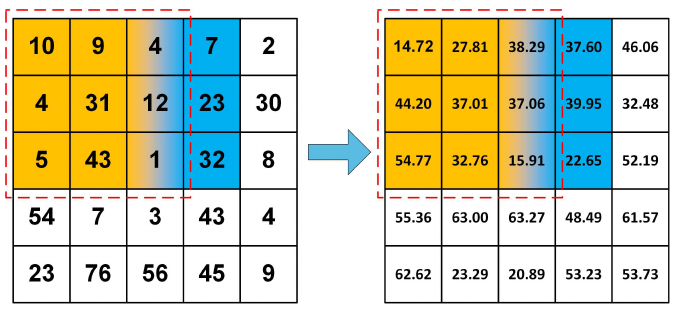
Figure 3. The calculation process of the slope